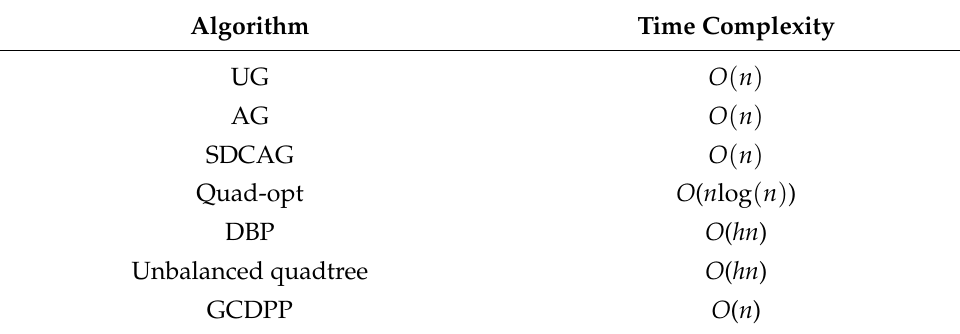
Table 2. Comparison of time